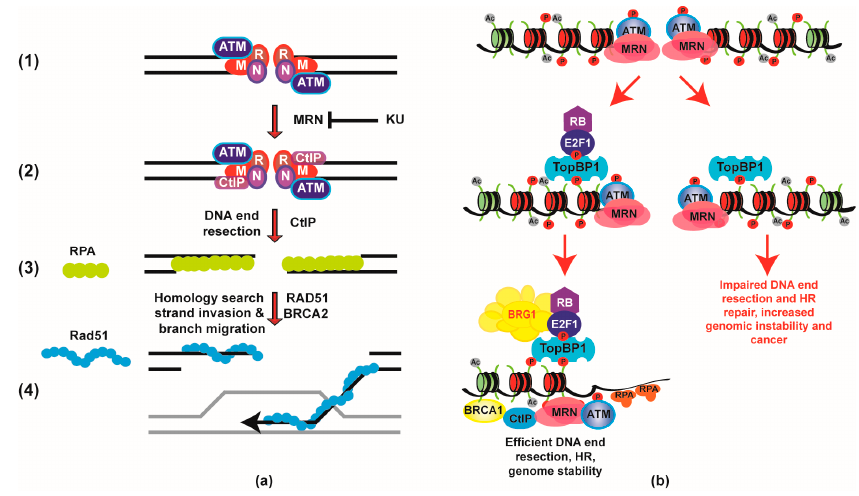
Figure 1. ( a ) The homologous recombination (HR) repair pathway involves multiple steps: (1) double strand breaks (DSB) recognition by the MRE11-RAD50-NBS1 (MRN) complex and the Ataxia telangiectasia mutated (ATM) kinase; (2) the CtIP nuclease is recruited to the DSB to initiate DNA end resection; (3) the replication protein A (RPA) coats the single-stranded DNA (ssDNA) regions and activates the ATM RAD3-related (ATR) kinase; (4) the breast cancer susceptibility gene 2 (BRCA2) protein mediates the replacement of RPA by the RAD51 recombinase, which will catalyze the homology search and the progression of HR; ( b ) RB is recruited to DSB through the TopBP1-E2F1-RB complex, which recruits the BRG1 ATPase. BRG1 stimulates DNA end resection and HR by reducing the nucleosome density at the break site. In the absence of RB, there is no decrease in nucleosome density at the break site, which impairs DNA end resection, HR, and promotes genomic instability.